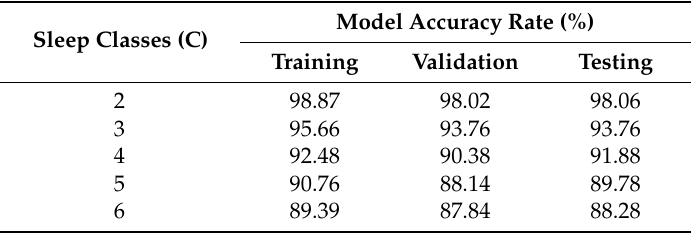
Table 4. Performance values for sleep-edf data of the model for two to six classes using a single electrooculogram (EOG)